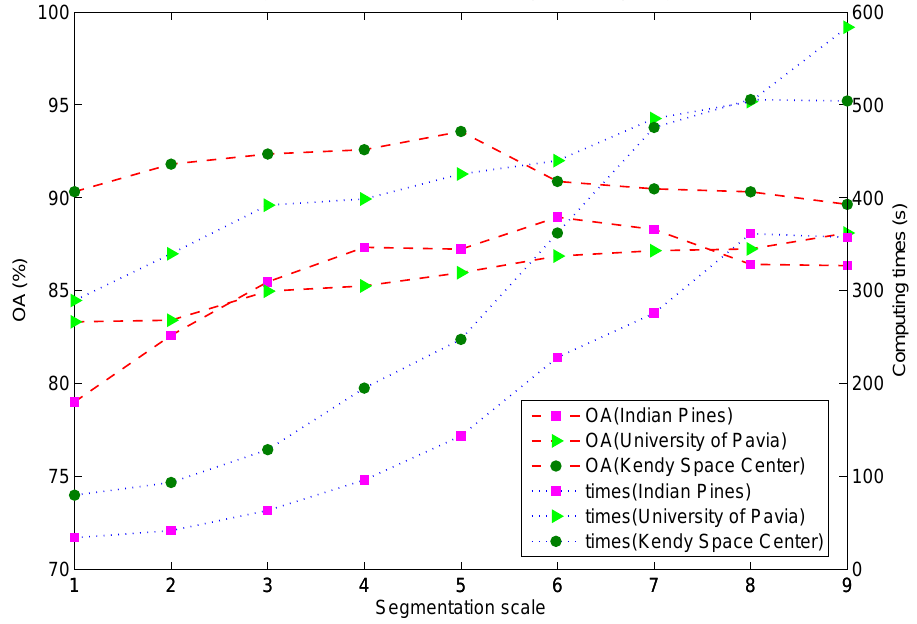
Figure 8. The effect of the different segmentation size on OA accuracy and computing times for three